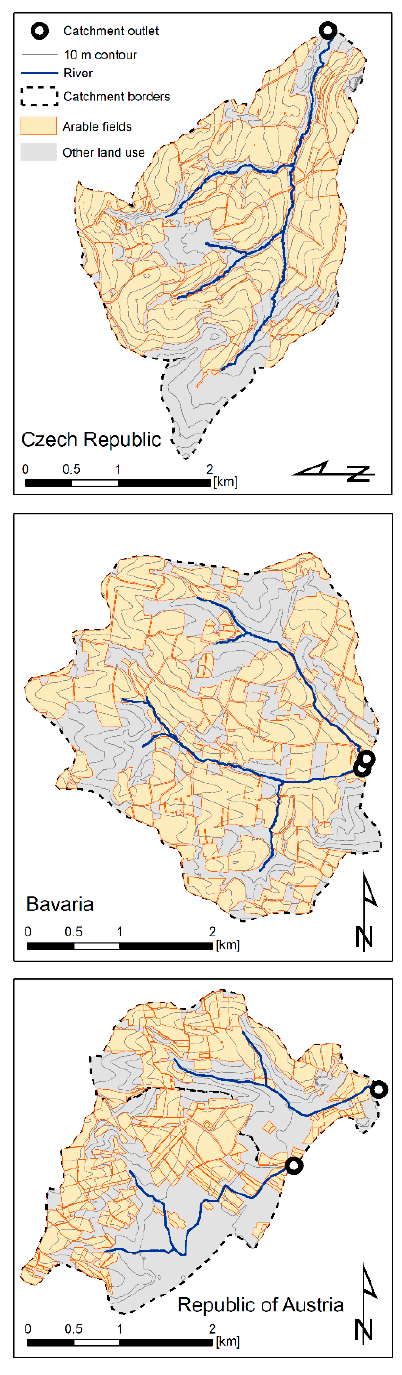
Figure 1. Topography and land use of test catchments.